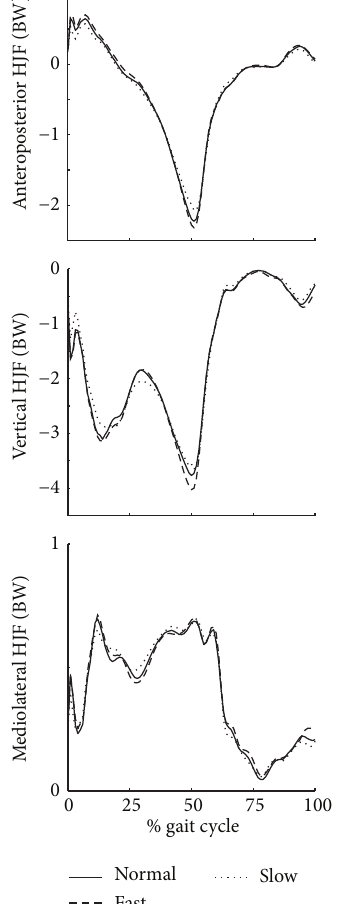
Figure2:Meanensemblecurvesoftheanteroposterior,vertical,and mediolateral hip joint force (HJF) during the gait cycle. Solid line represents the normal walking condition, dashed line represents the fast walking condition, and dotted line represents the slow walking condition.